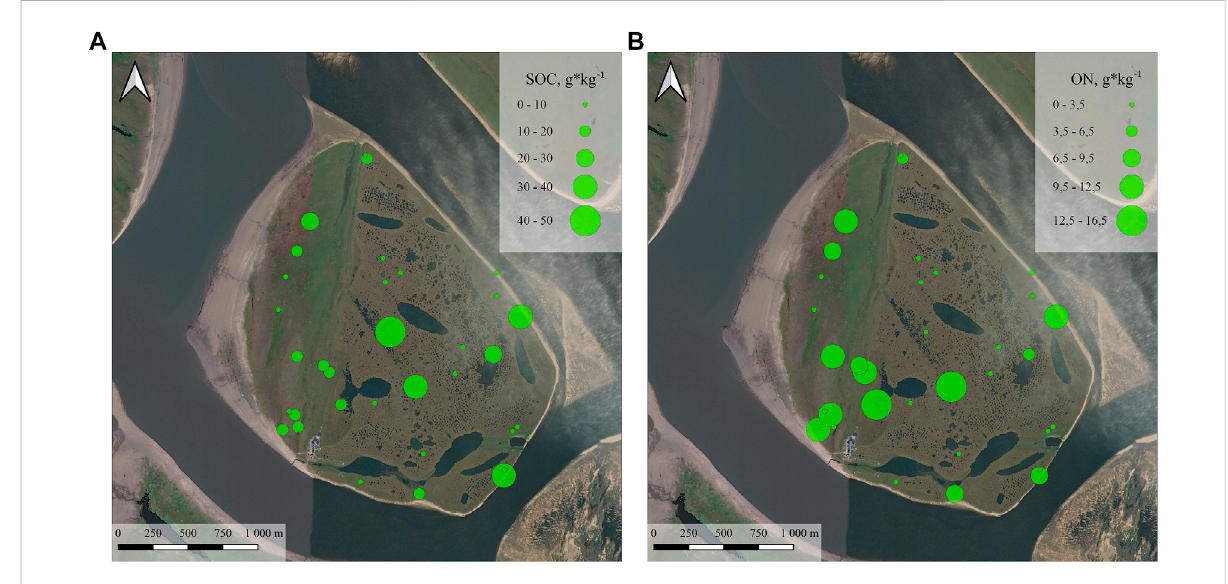
FIGURE 9 Spatial distribution of SOC (A) and ON (B) in soils of the Lena River